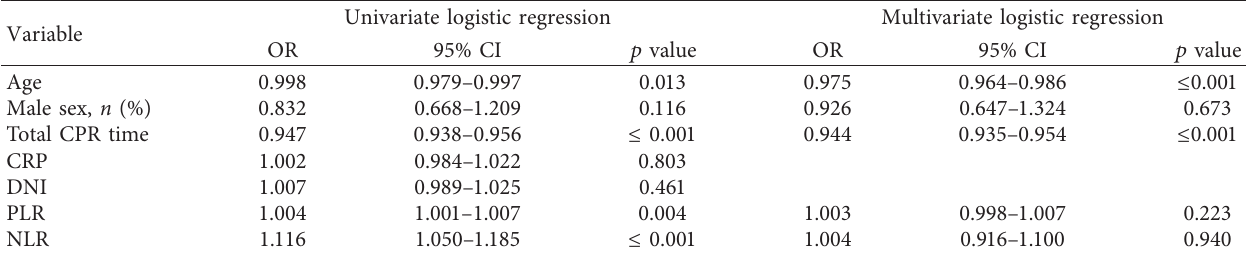
Table 2: The predictive factors for the primary outcome (ROSC).